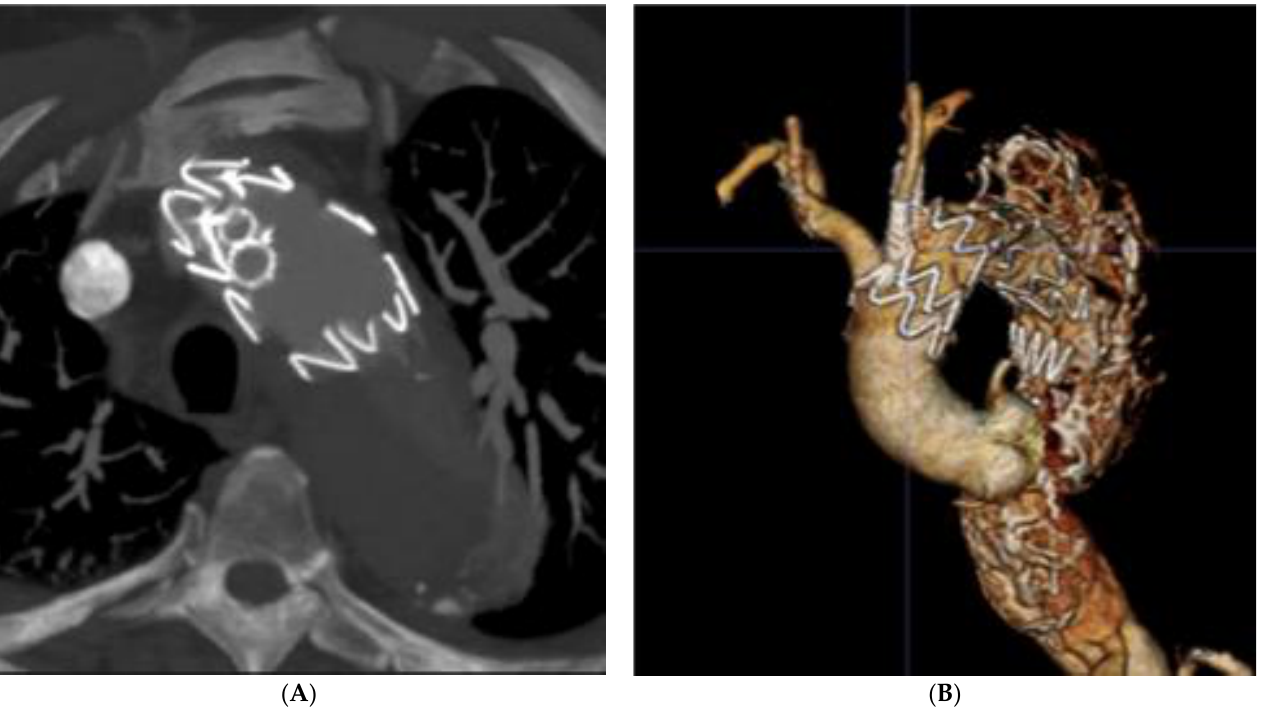
Figure 4. Post-operative CT scan 3D volume rendering ( A ) of the in situ laser fenestrations of the left common carotid and left subclavian arteries. The 3D reconstruction ( B ) shows fenestrations position and patency.